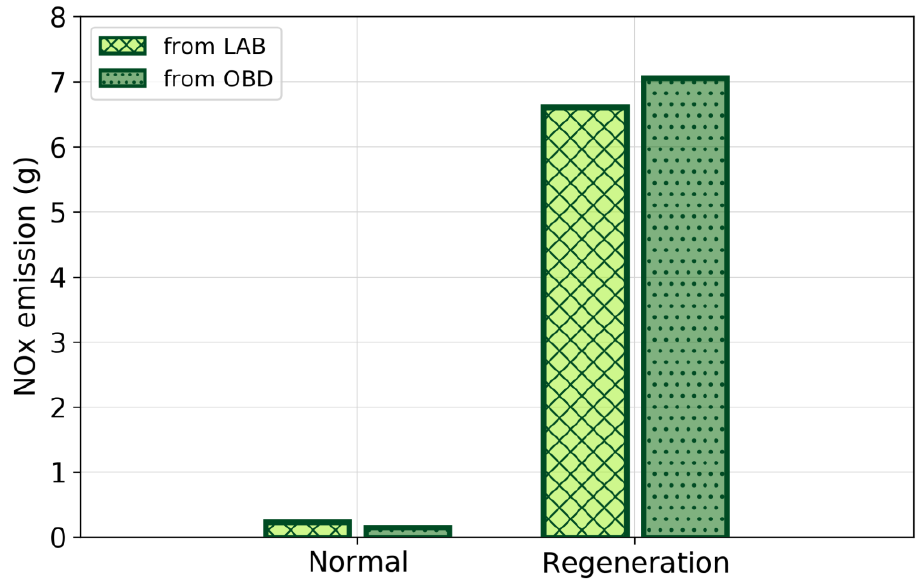
Figure 7. The cumulative NOx emissions measured in the laboratory and by OBM in WLTC cycles performed under normal SCR functioning conditions and under DPF regeneration conditions.